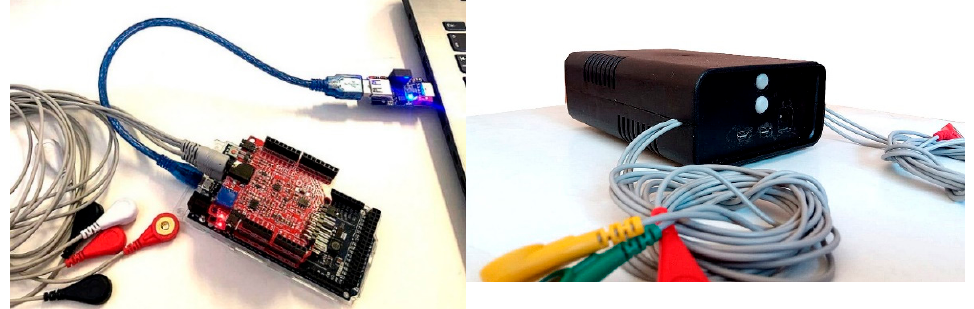
Figure 7. ( Left ) The Arduino DUE board with two modified Olimex ECG/EMG shields connected to the laptop USB socket using a 2.5 kV USB digital isolator based on Analog Devices ADuM3160 chip. ( Right ) The enclosed system ready to operate.